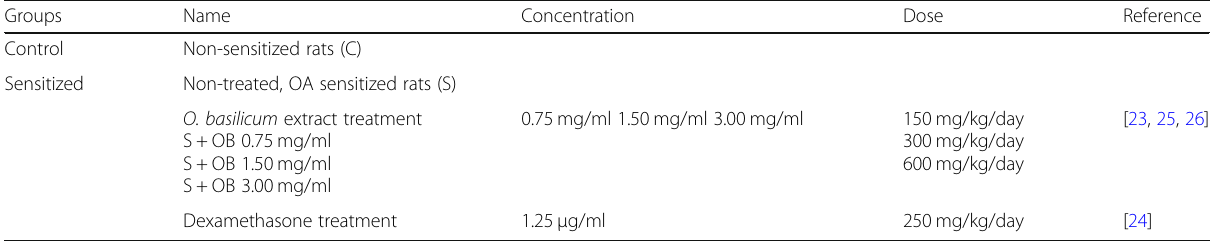
Table 1 Studied groups (randomly divided) Groups